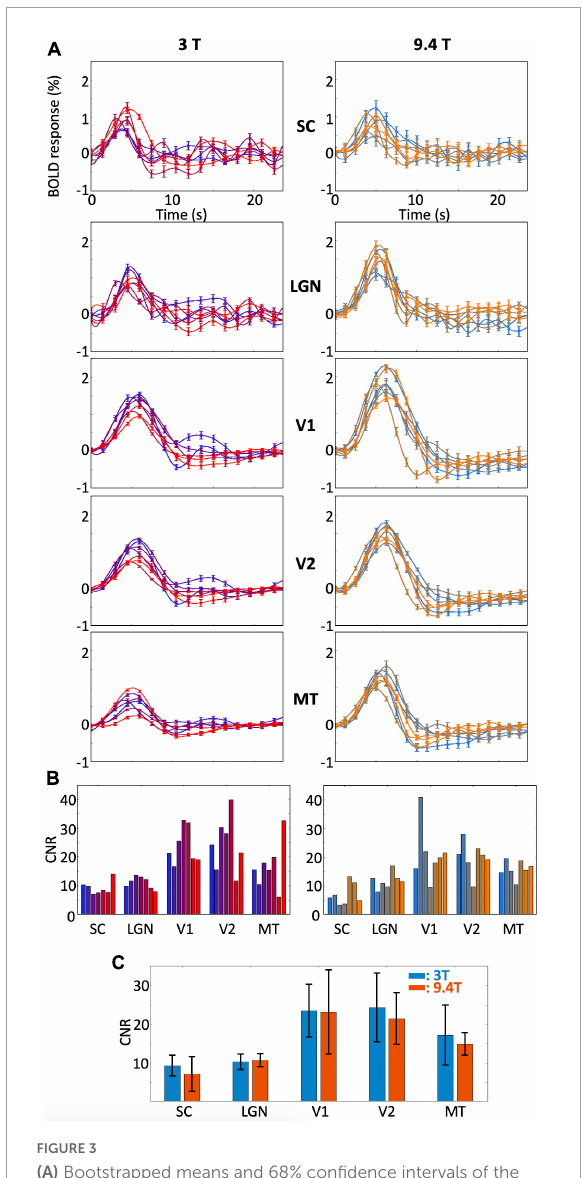
FIGURE3 (A) Bootstrapped means and 68% confidence intervals of the HRF in each ROI for each subject and (B) CNR within all subjects. Results are shown for 3T (left) and 9.4T (right). Different colors represent different subjects. (C) Means and standard deviations of CNRs across subjects for each